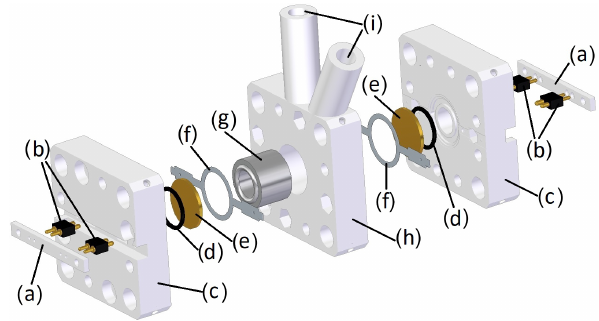
Figure 4. Exploded view of the chamber housing consisting of (a) the counter bar, (b) spring pins for contacting the quartz elec- trodes, (c) the side parts, (d) the O-rings, (e) the quartz disks, (f) the contact ring, (g) the sample chamber, (h) the middle part and (i) the holes for syringes with injection needles.